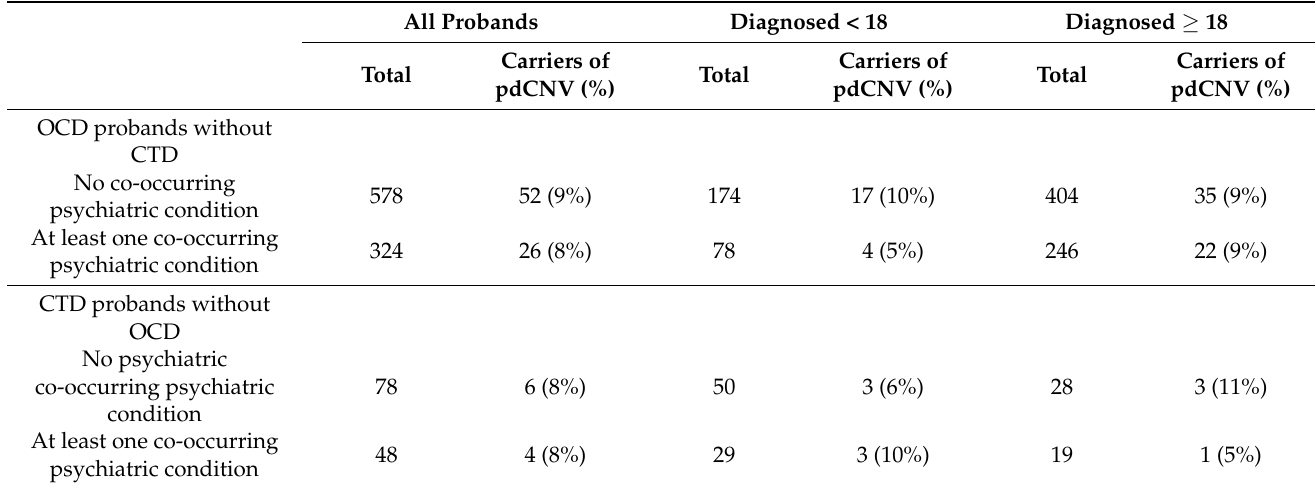
Table 5. OCD and CTD probands with and without co-occurring psychiatric